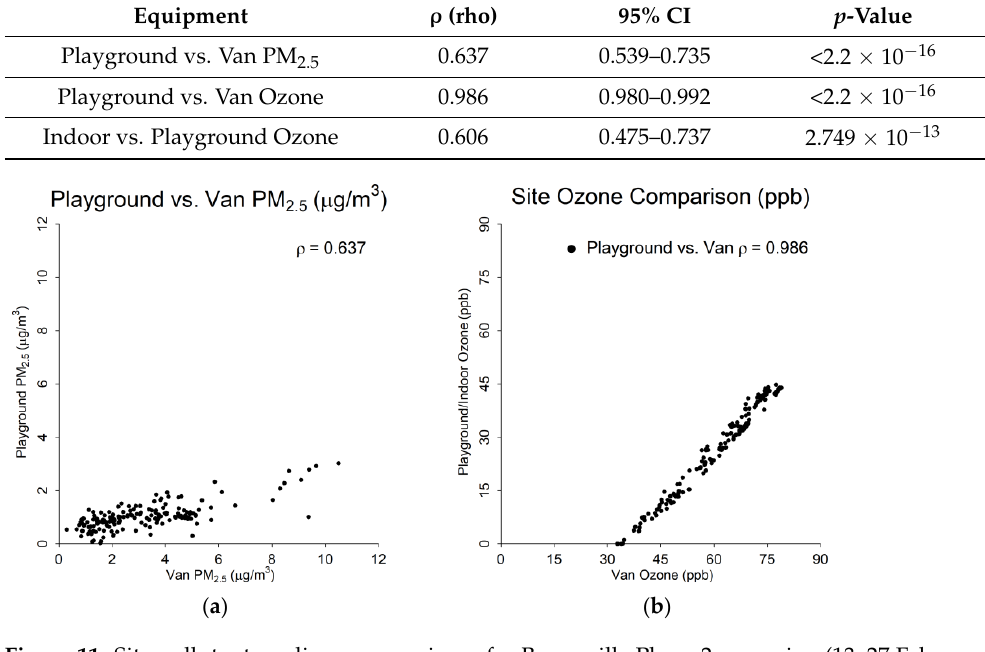
Table 9. Bonneville Elementary Idle-Free Campaign vehicle counts and idling time.